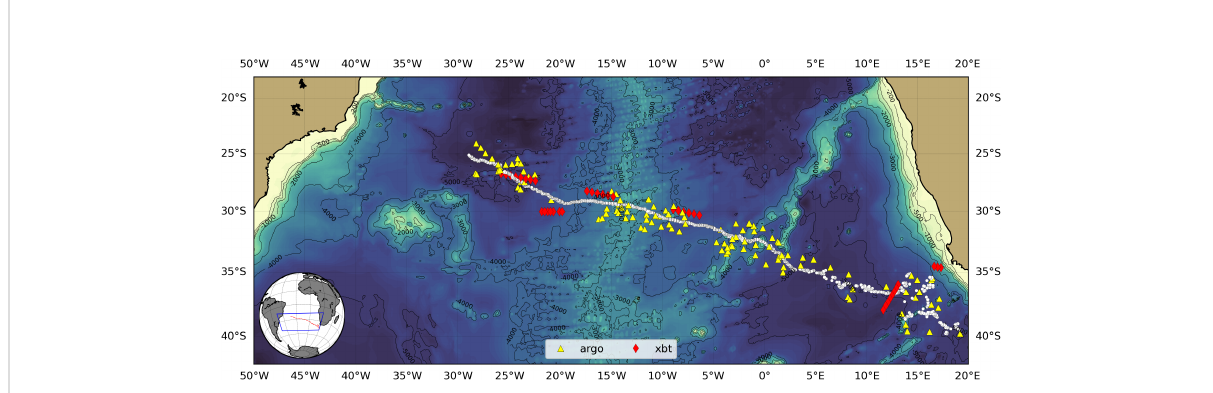
FIGURE 9 The path of the Ring Eliza between 01-Aug-2007 and 04-May-2010 (white dots) and the locations of Argo (yellow) and XBT (red diamonds) pro fi les within the ring radius. The bottom topography is shown in the background.